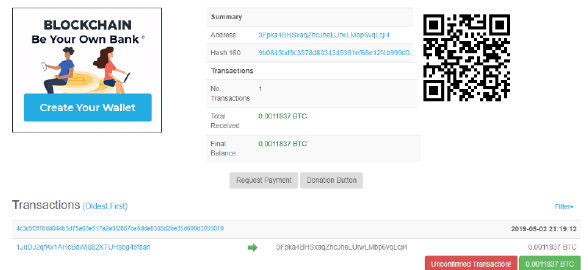
Figure 2. Blockchain.info verifying that the transaction